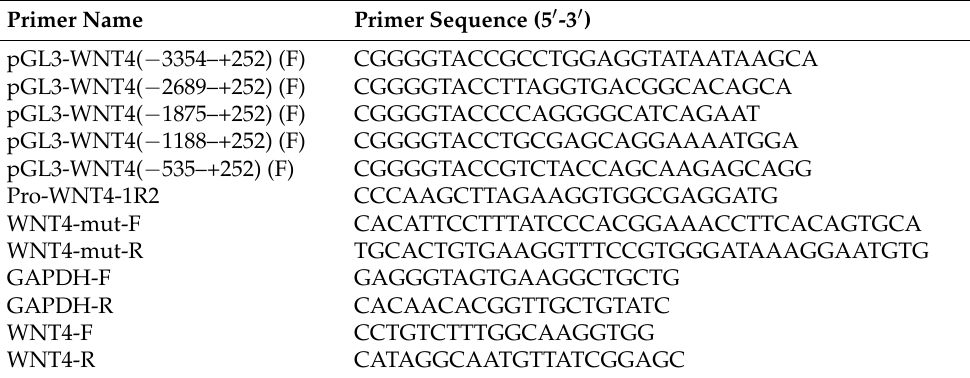
Table 1. Primers used in this